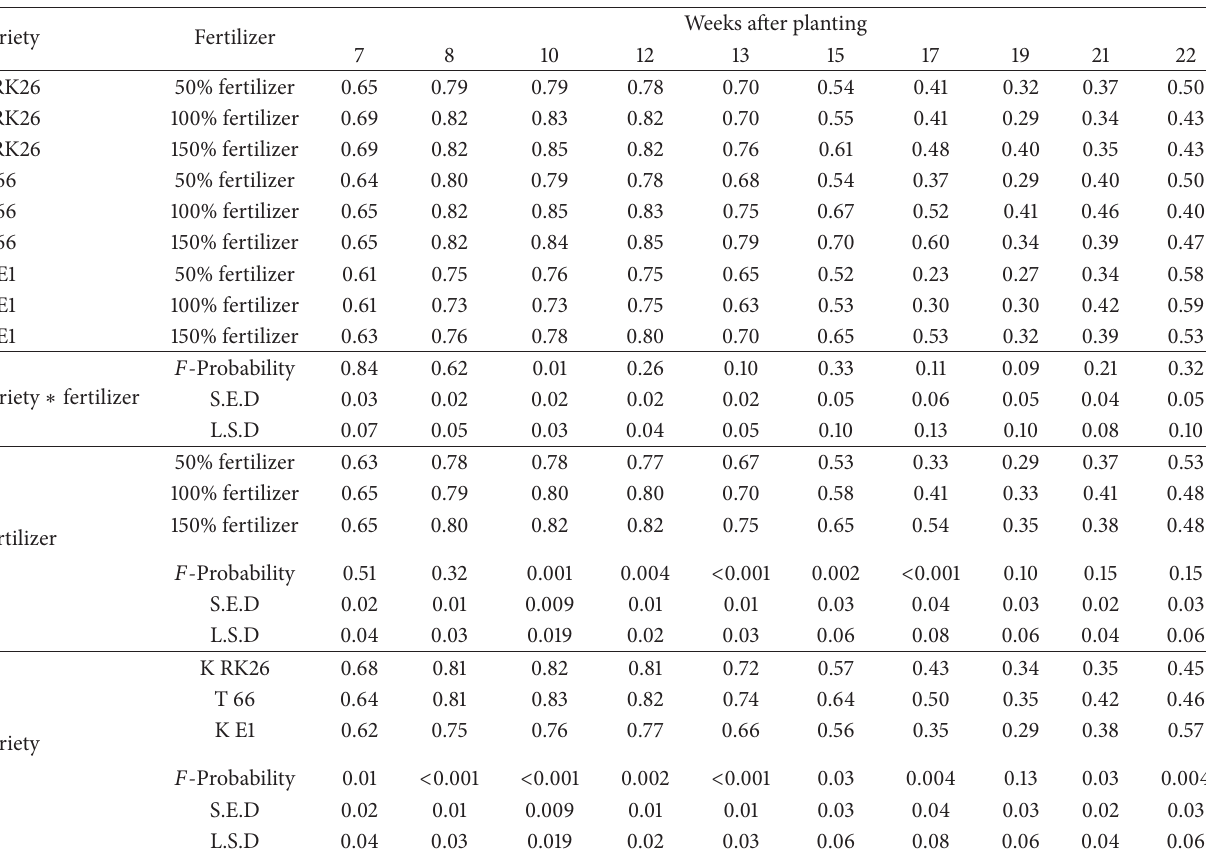
Table 3: The NDVI temporal profiles for the September 15 planted crop.